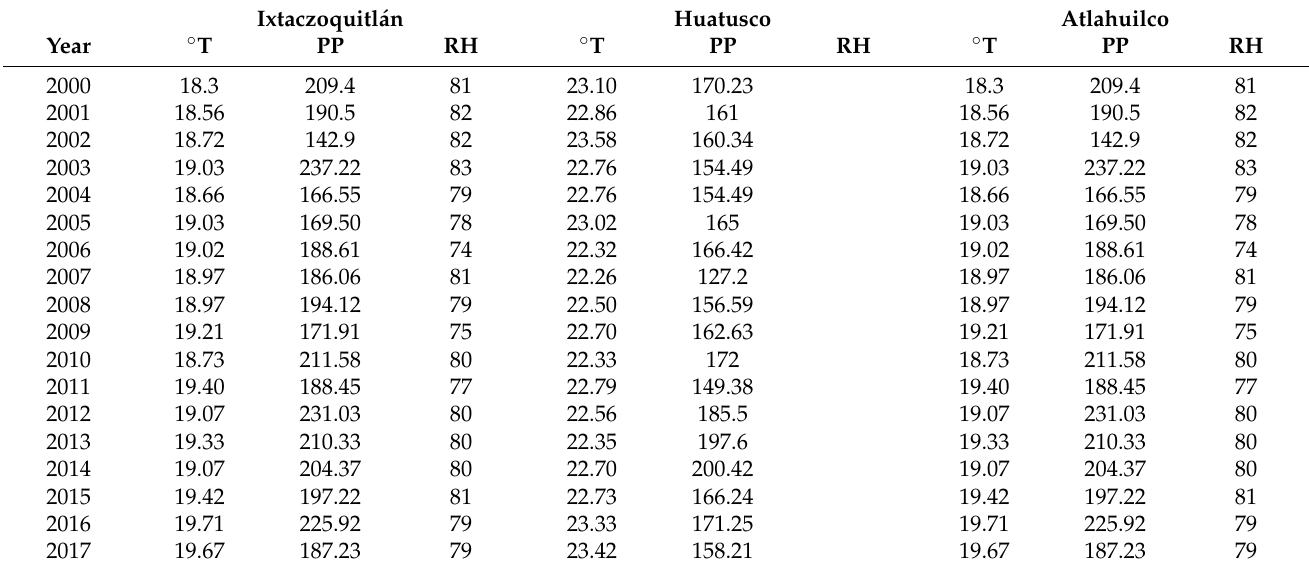
Table 3. Climatological data for the three study sites (CONAGUA, 2018).